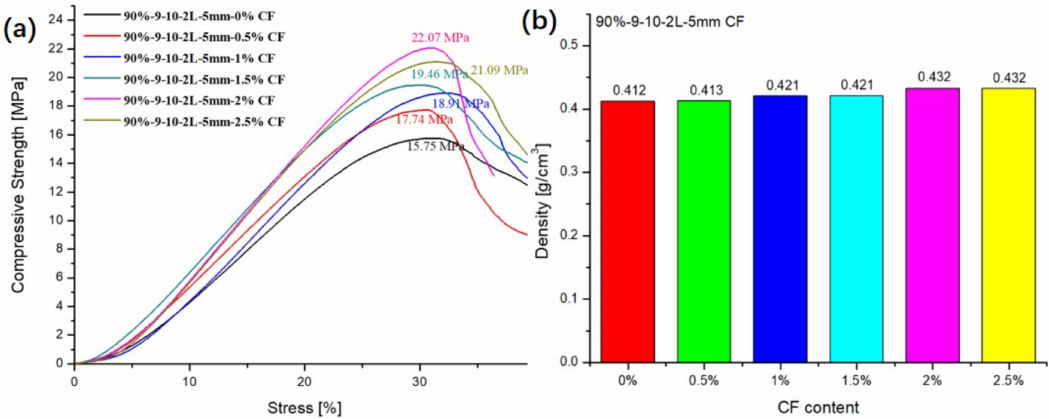
Figure 12. Influence of the content of CF in CFR-EP: ( a ) compressive strength and ( b )